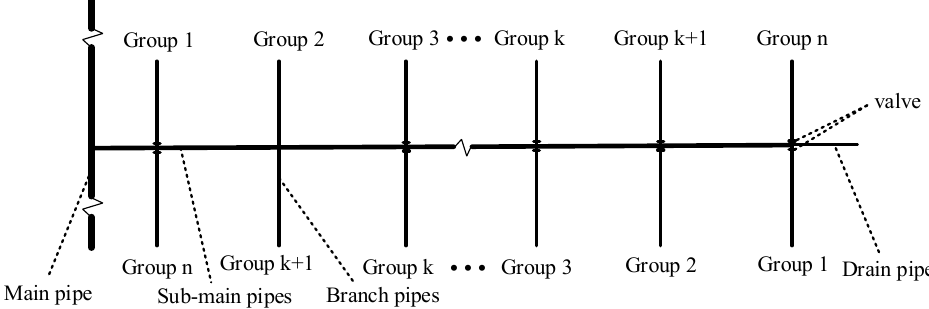
Figure 2. The grouping method of rotation irrigation of the two branch pipes working simultaneously.